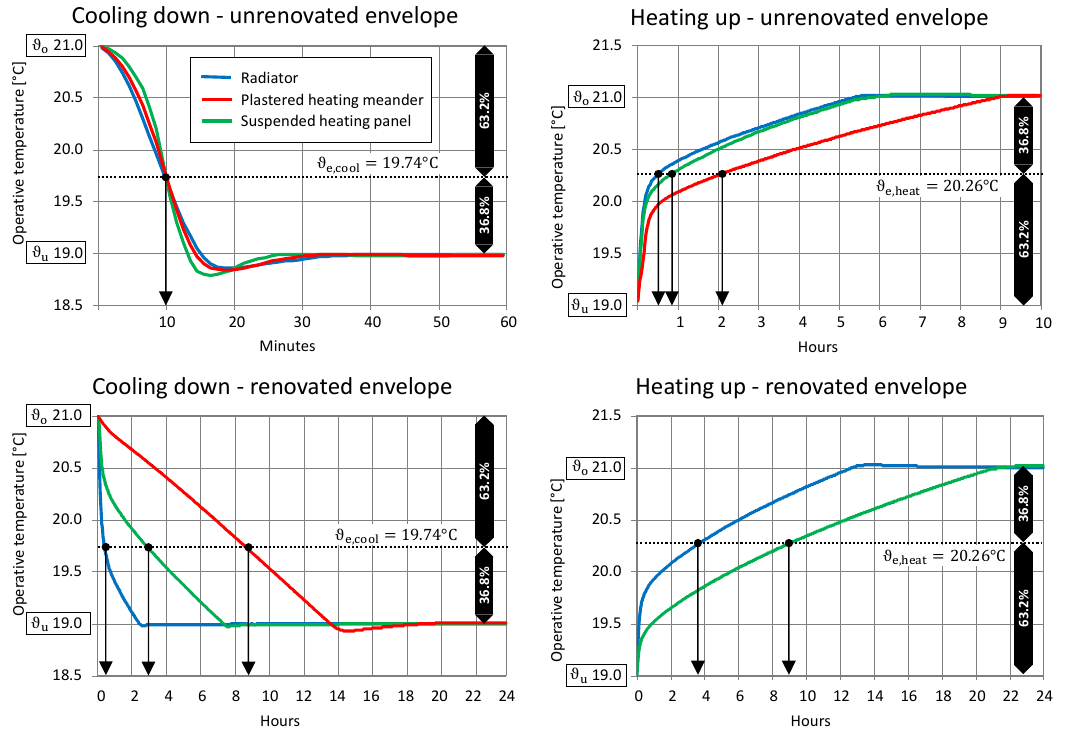
Figure 8. Time constants for the 2nd–4th floor for cooling and heating processes. The cooling-down behaviour described above can also be transferred to heating-up events. Here, too, the RAD (31 min) and the SHP (50 min) show the fastest reaction, while the PHM needs approximately 2 h to heat up the room from 19.00 ◦ C to 20.26 ◦ C due to the strong coupling with the storage mass. Since the installed capacity of the heat transfer systems is lower after the façade renovation, but the available storage mass remains constant, the time constants become significantly greater. The RAD requires approximately 3.5 h, while the SHP reaches ϑ e,heat only after approximately 9 h [41]. The PHM cannot reach the setpoint temperature at all due to the supply temperature limitation and the time constants are therefore not